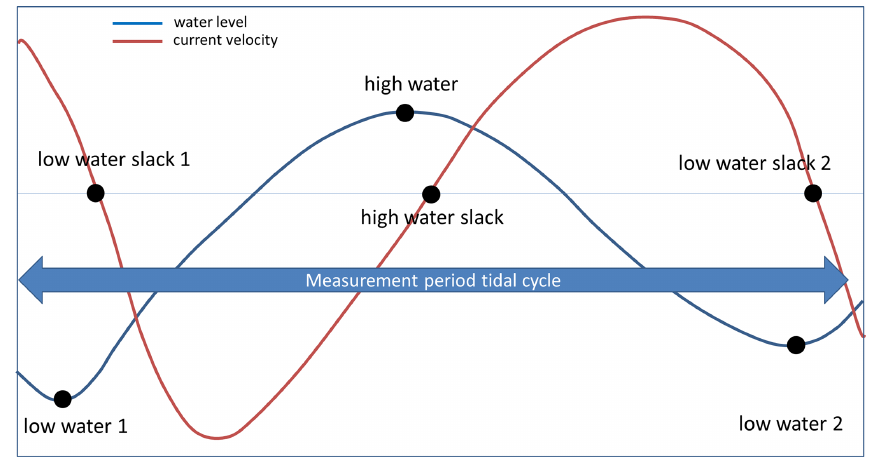
Figure 2. Definition of the measurement period of the 13h